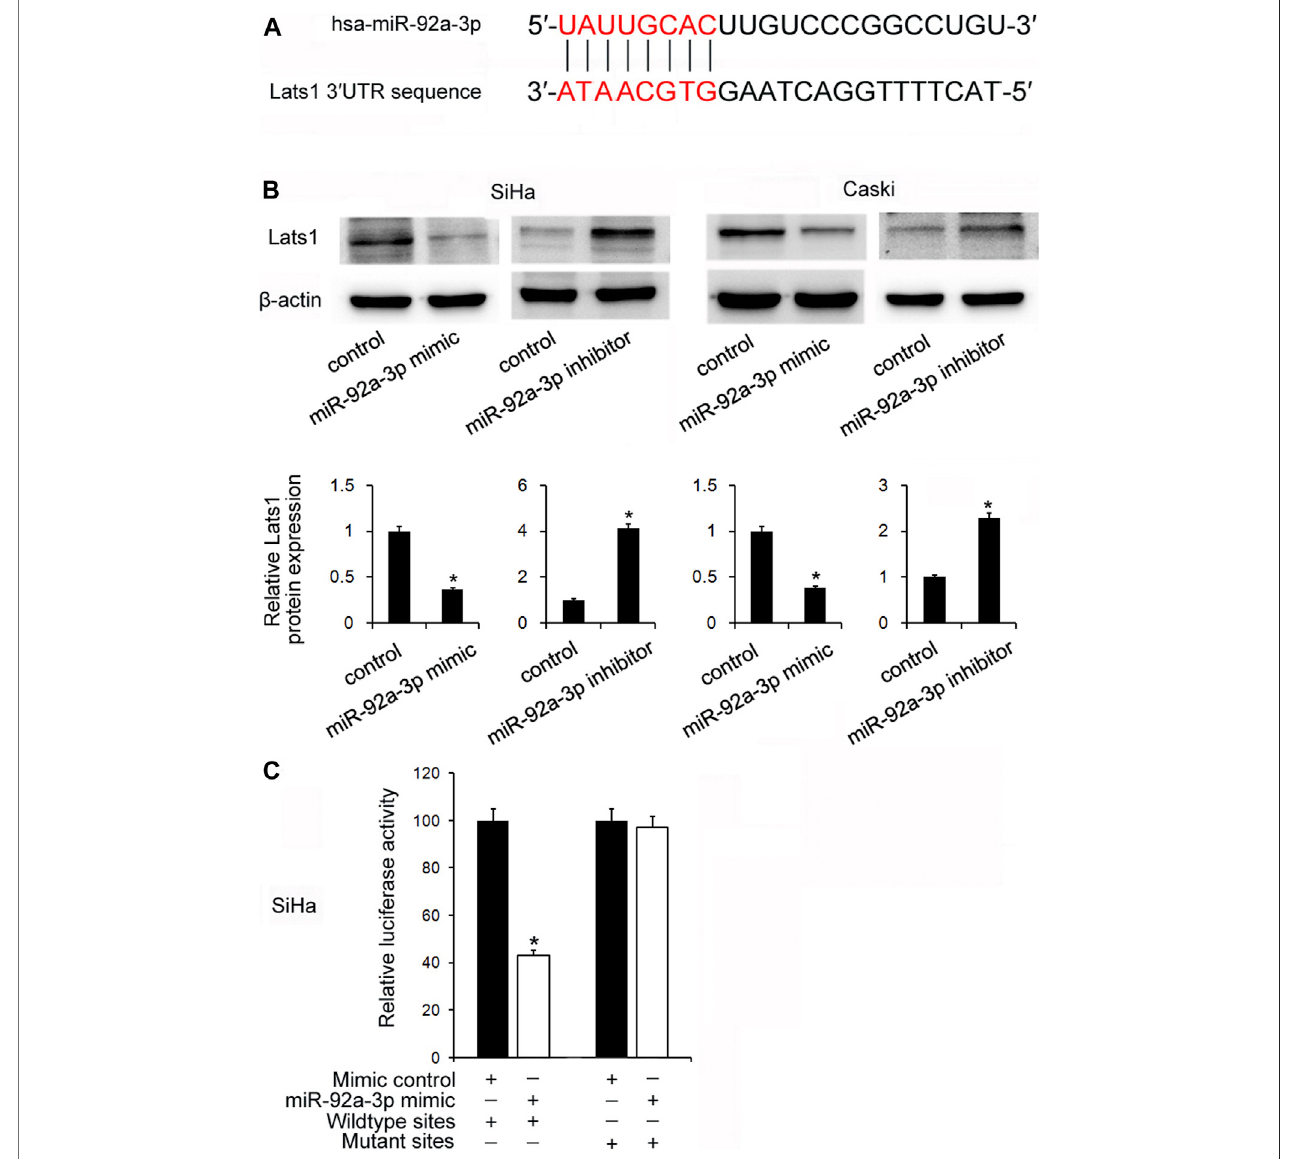
FIGURE 3 | miR-92a-3p targeted large tumor suppressor 1(LATS1)in cervical cancer. (A) The potential binding site between miR-92a-3p and LATS1 3 ′ -UTR. (B) The miR-92a-3p mimic/mimic control and miR-92a-3p inhibitor/inhibitor control were transfected into SiHa and Caski cells respectively. Western blotting showed that LATS1 was decreased after miR-92a-3p mimic transfection and increased after miR-92a-3p inhibitor transfection. (C) miR-92a-3p mimic/mimic control and wild type/ mutant reporter plasmid were co-transfected into the SiHa cells. miR-92a-3p mimic downregulated luciferase activity in cells transfected with the LATS1-wild type reporter plasmid. * p <